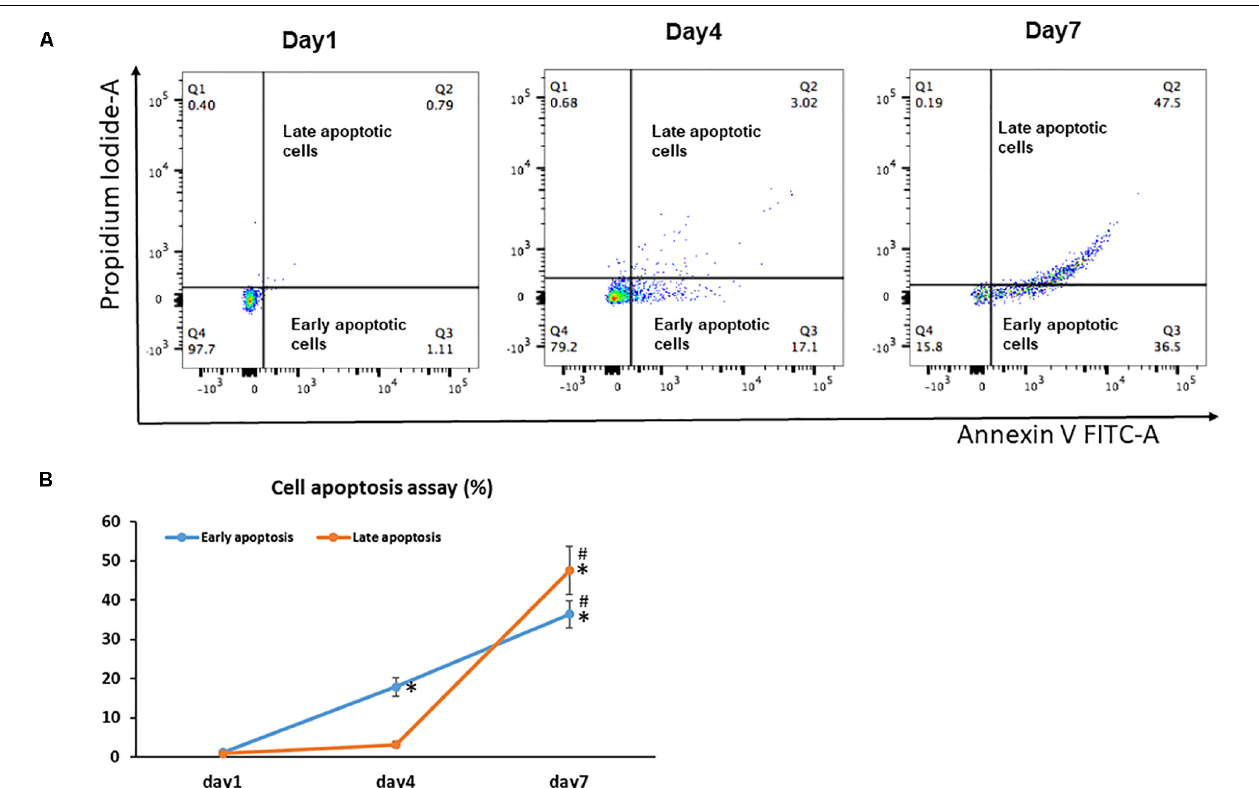
FIGURE 2 | Cell apoptosis in BMSC sheet cultures. Cells from Days 1, 4, and 7 cultures were stained with Annexin V and PI, and the populations corresponding to viable and non-apoptotic (Annexin V– PI–), early (Annexin V+PI–), and late (Annexin V+PI+) apoptotic cells. (A) Representative flow cytometry graphs of cell apoptotic analysis. (B) The percentage of early apoptotic cells and the percentage of late apoptotic cells in Days 1, 4, and 7 cultures. Results are mean ± SD. All experiments were performed in triplicate. * P < 0.05 vs. Day 1 cells and # P < 0.05 vs. Day 4